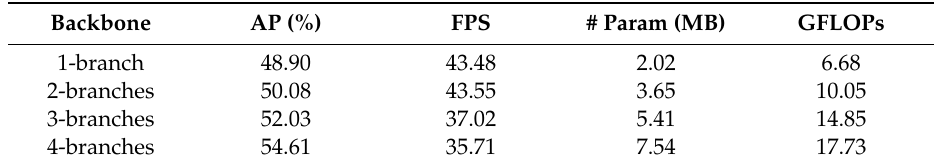
Table 3. In the table, 1-branch means that no parallel branch is introduced, but only one branch; 2-branches means that one parallel branch is introduced, a total of 2 branches; and so